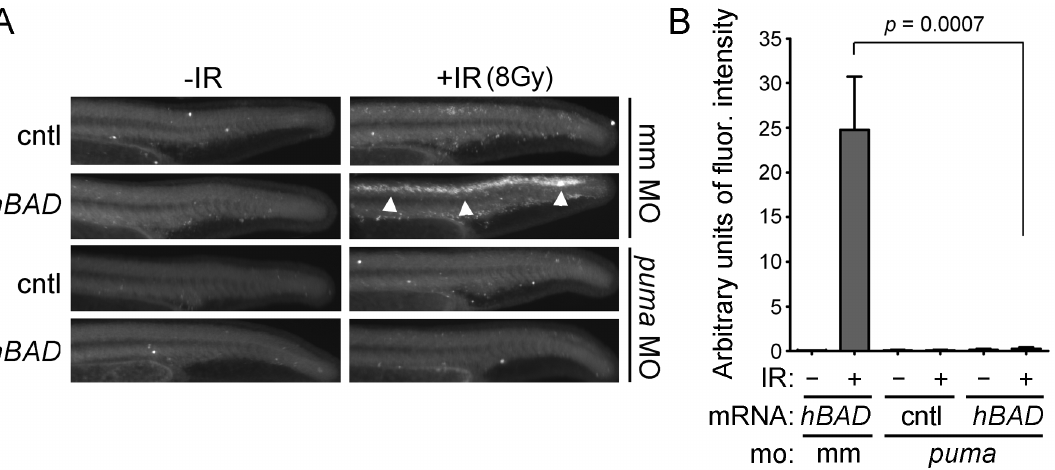
Figure 5. Bad radiosensitizes zebrafish neural tissue through the mitochondrial apoptosis pathway. (A) Shown are lateral views of 27- hpf wild-type embryos (head is top left in each panel) injected with either 1) 50 pg of egfp mRNA, 2) 25 pg each of egfp and bad, 3) 25 pg each of egfp and zbcl-xL , or 4) 25 pg each of bad and zbcl - xL . At 24 hpf, half of each group was irradiated with 8 Gy IR and analyzed three hours later by the Casp3 assay. (B) Fluorescence intensity was measured in the spinal cords of at least 10 embryos from each group. Data represent one experiment, but the experiment was independently performed three times with similar results.